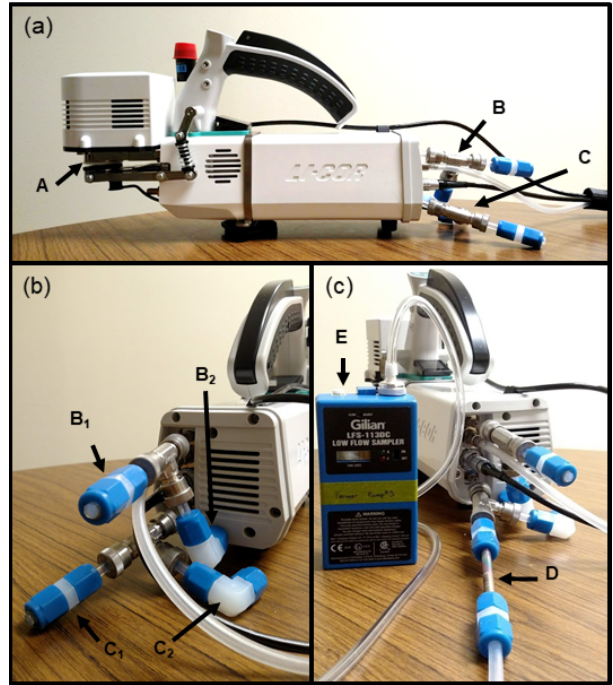
Figure 2. Photograph of the emissions subsampling manifold for the LI-6800. The profile view (a) highlights the leaf chamber (A), SAM subsampling port (B), and REF subsampling port (C). The back view (b) highlights the SAM and REF sampling ports (B 1 and C 1 , respectively) and overflow ports (B 2 and C 2 , respectively). Panel (c) shows an example setup of sorbent tube (D) emission col- lection with an external pump (E) sampling the REF subsampling